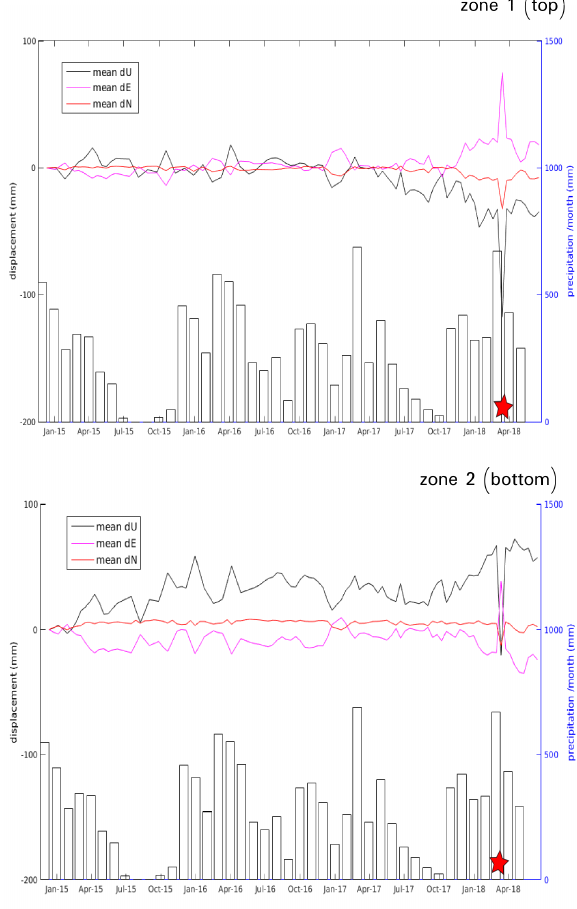
Figure 7. InSAR displacements in U, E, N directions at zone of depletion (1) and zone of accumulation (2) in the Puncak Pass landslide along with the total precipitation (/month). The red star indicates the date of two consecutive landslides occurred in February and March 2018. The correlation values between displacement vectors and precipitation are -0.04, 0.25, -0.22 (zone 1) and 0.22, -0.07, -0.2 (zone 2).